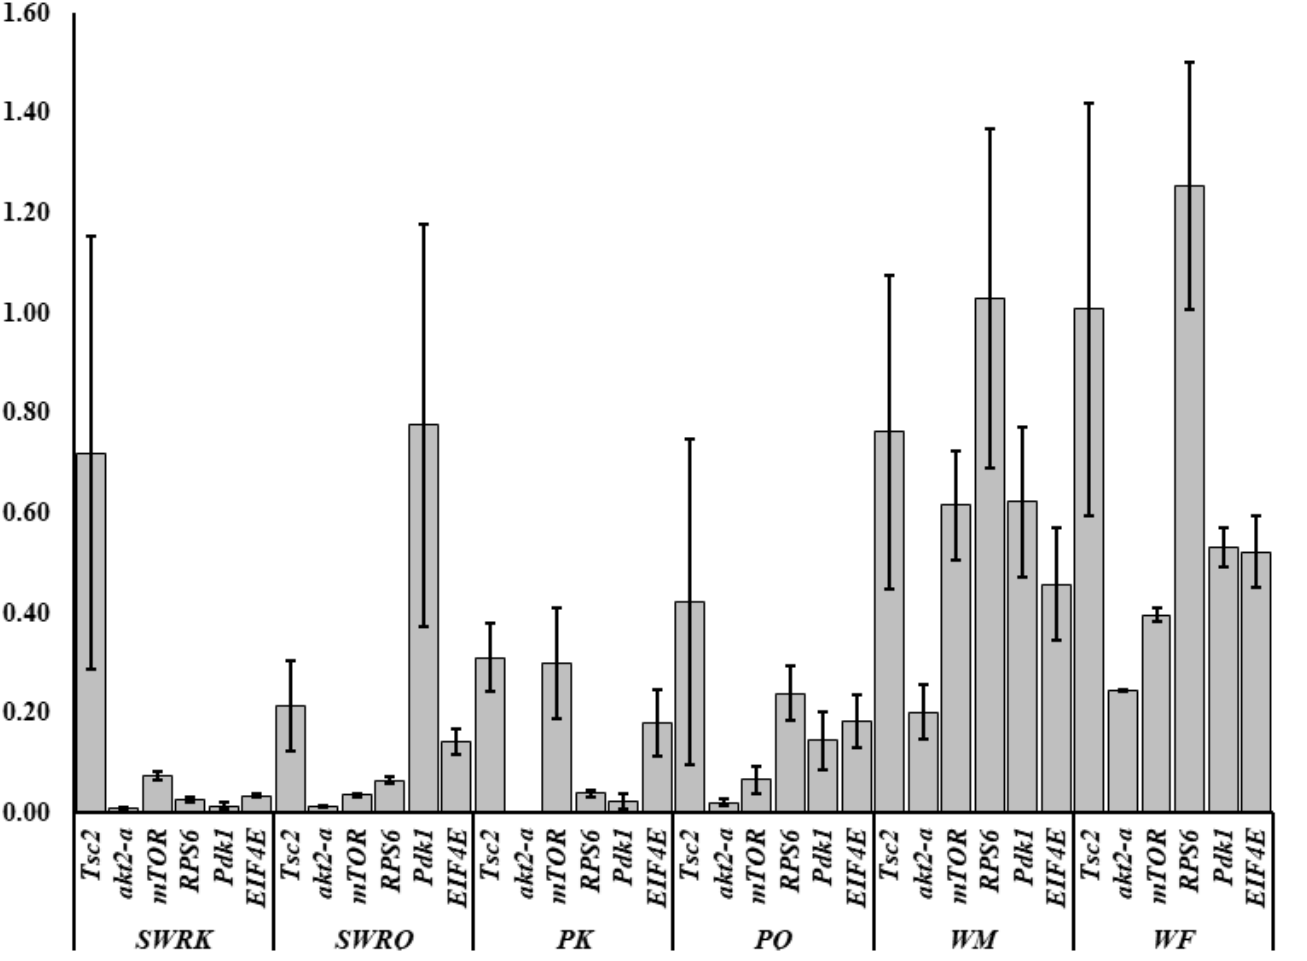
Figure 6. Log2 fold changes in the insulin signaling pathway in R. chinensis castes SWRK, SWRQ, PK, PQ, WM, and WF. Differential expression of genes in each group is shown as log2 fold changes compared to the reference group. The y-axis represents the log2 fold changes, and the x-axis shows the gene name and individual caste name.